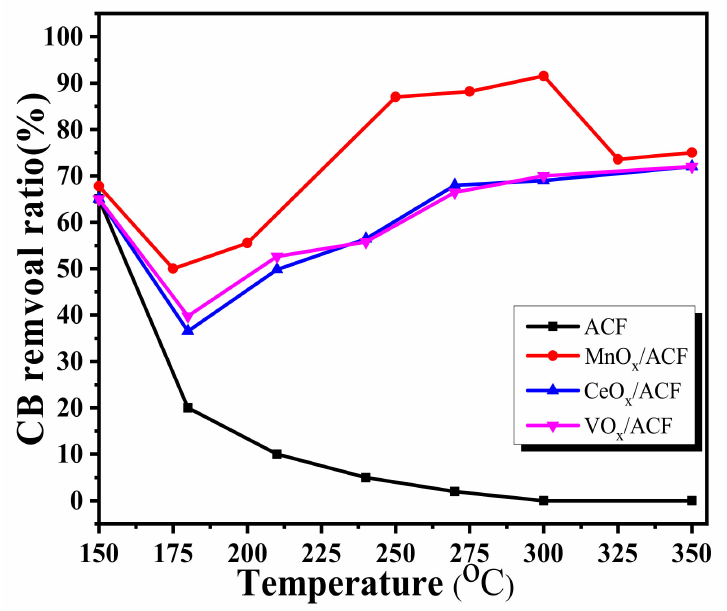
Figure 8. Adsorption/catalytic oxidation of CB over MOx@ACF with various transition metal oxides. ( C inlet,CB = 5000 ppm, Gas flow rate = 100 SCCM, GHSV = 20,000 h − 1 , 21% O 2 , N 2 balance, dwell time = 3